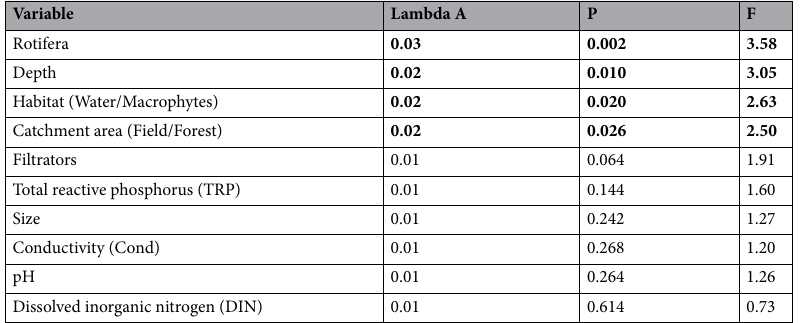
Table 7. Results of RDA on relation between abundance of chlorophyte functional gropus and number of taxa and physical–chemical and biological parameters among different habitats of field and forest ponds. Values of p and F are calculated using Monte Carlo permutation test with 999 permutations. The overall percentage of explained variance was 14.7%. Bold = variables significantly adding to the model at p < 0.05 level (see Fig. 3).